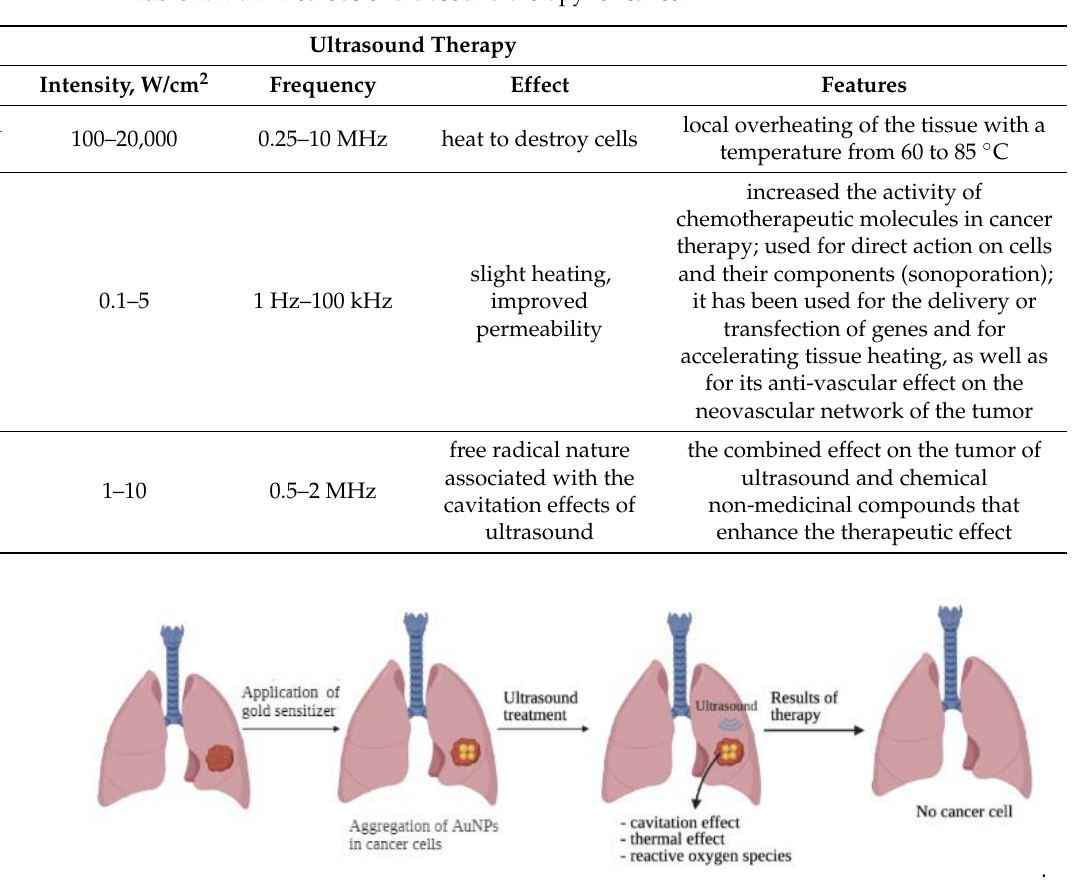
Table 1. Main methods of ultrasound therapy for cancer.